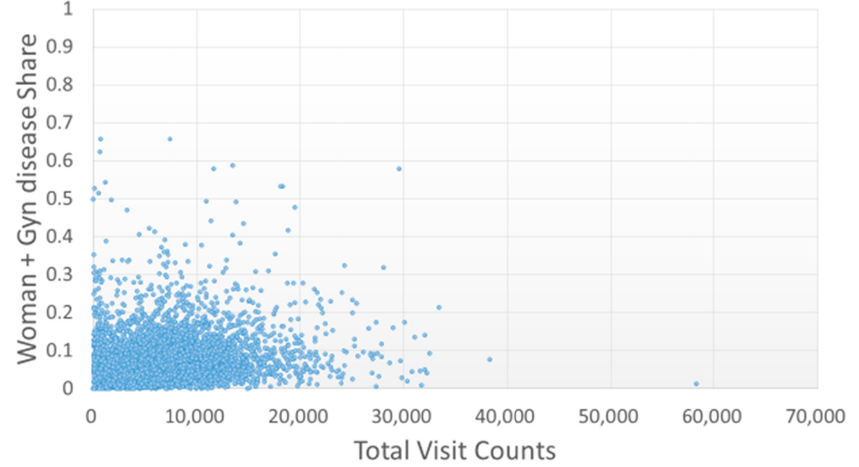
Figure 5. Distribution of gynecology-related treatments with total visit counts by each TCMP. A higher proportion indicates that the TCMP provided more gynecological treatments to female patients (Gyn disease).